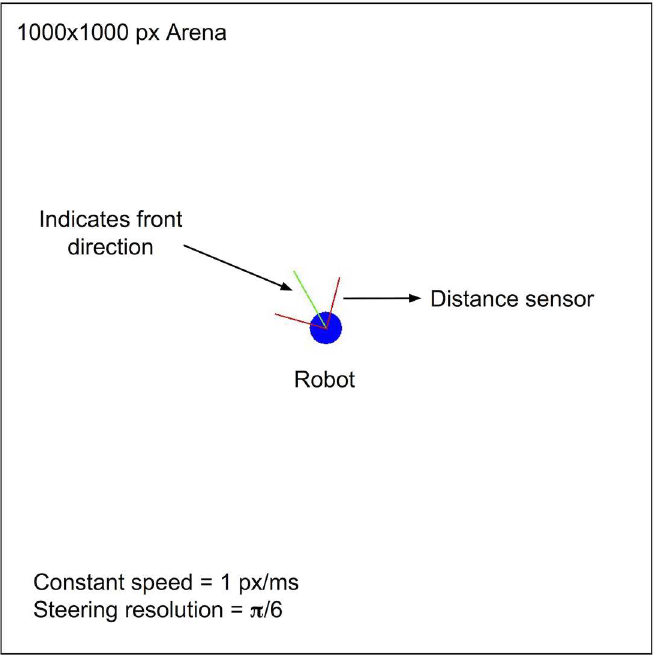
Fig 9. Robot simulation. The robot has distancesensors and must learn to stay away from the arena’s